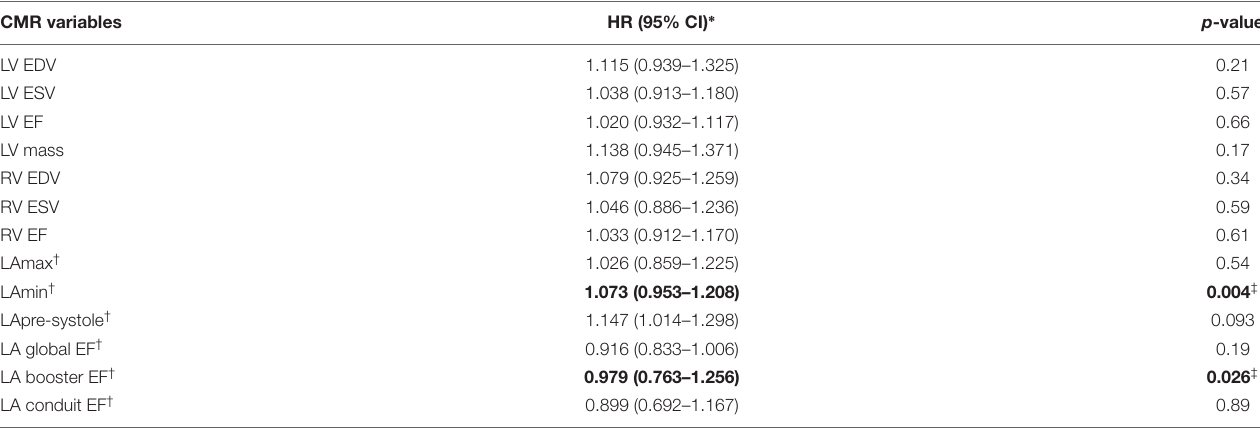
TABLE 5 | Univariable associations of Z-score values for CMR chamber volumes and ejection fraction with the primary clinical outcome in the overall cohort (both sexes).